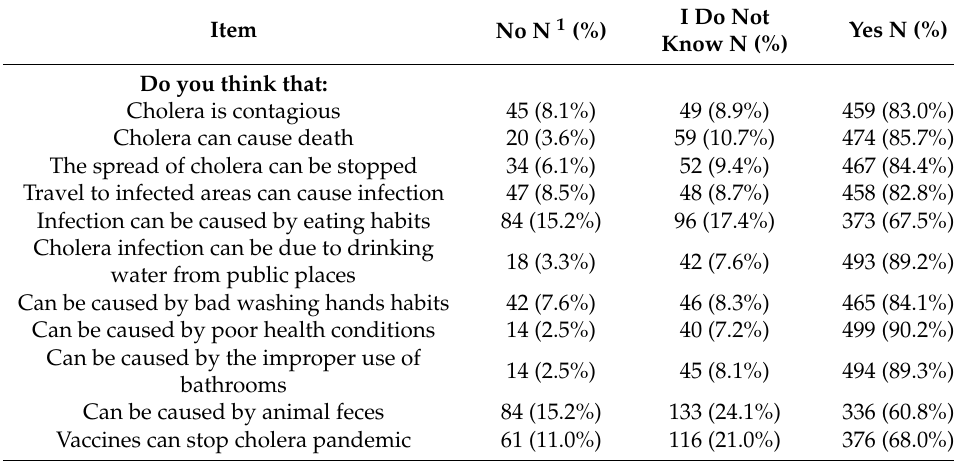
Table 3. Description of the cholera attitude items.